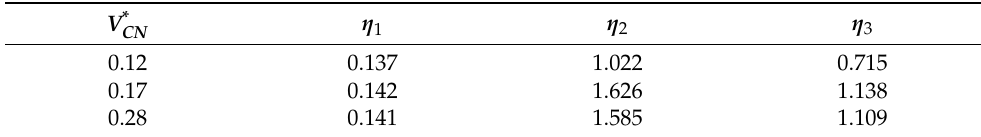
Table 3. Typical properties of CNT/matrix efficiency parameters depending on the volume fraction of CNTs.